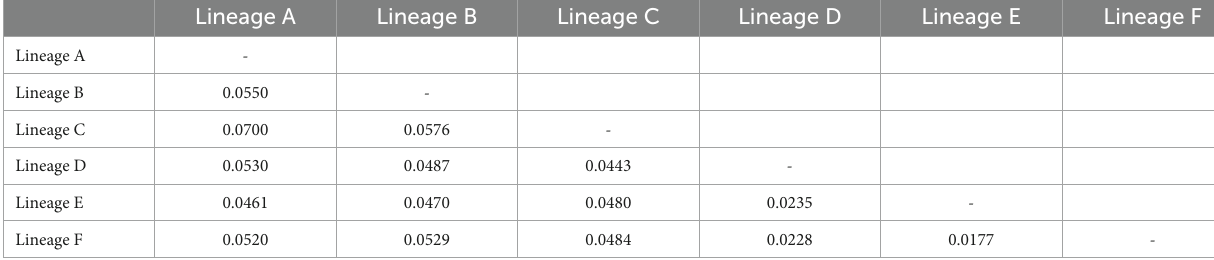
TABLE 2 Genetic distance between major lineages of O. acutipinnis-evolans complex based on Cyt b